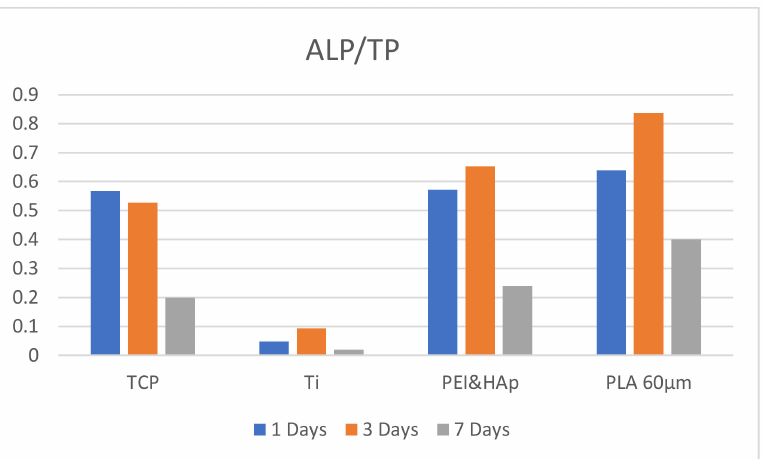
Figure 9. Ratios of Alkaline Phosphatase in osteoblasts seeded for 1, 3 and 7 days of incubation, on the following materials: Tissue culture polystyrene (TCP), Titanium (Ti), Hydroxyapatite reinforced Polyetherimide (PEI&HAp) and polylactic acid with 60 µ m pore side length (PLA 60 µ